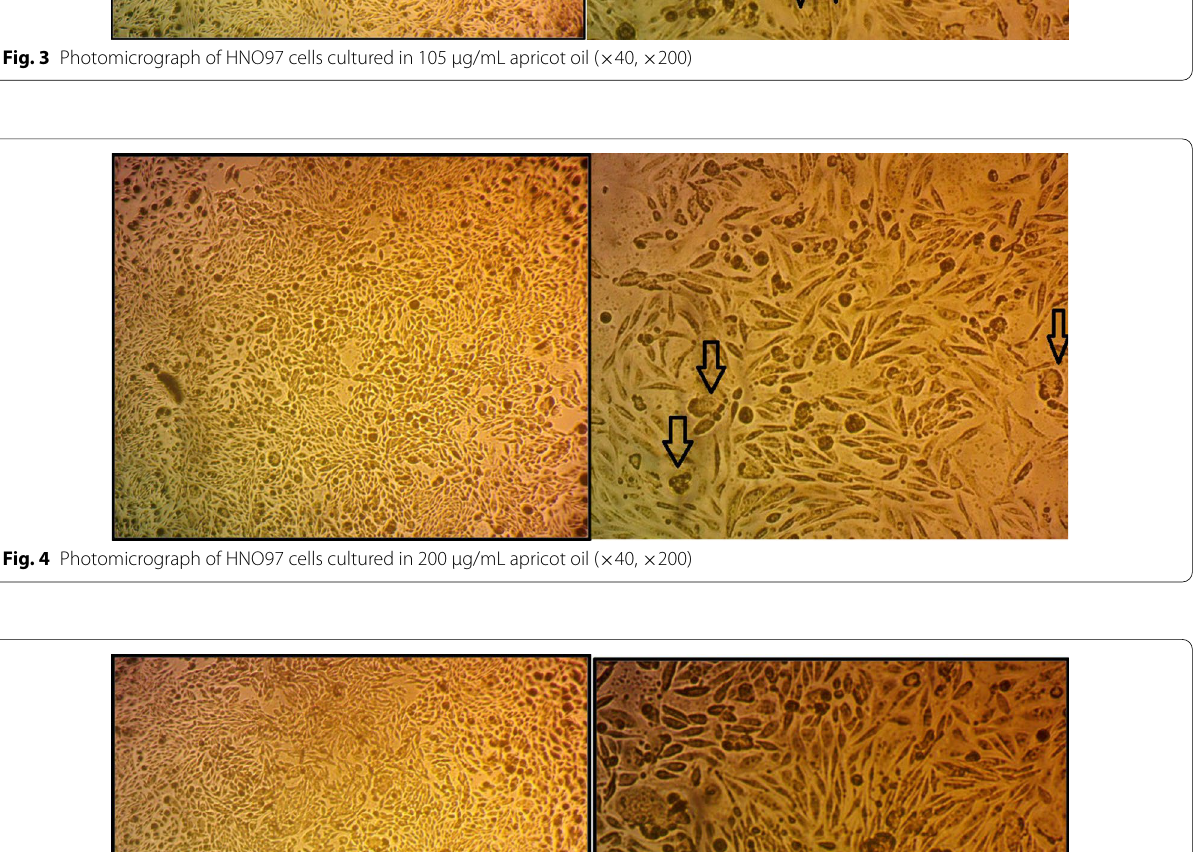
Fig. 3 Photomicrograph of HNO97 cells cultured in 105 µg/mL apricot oil (